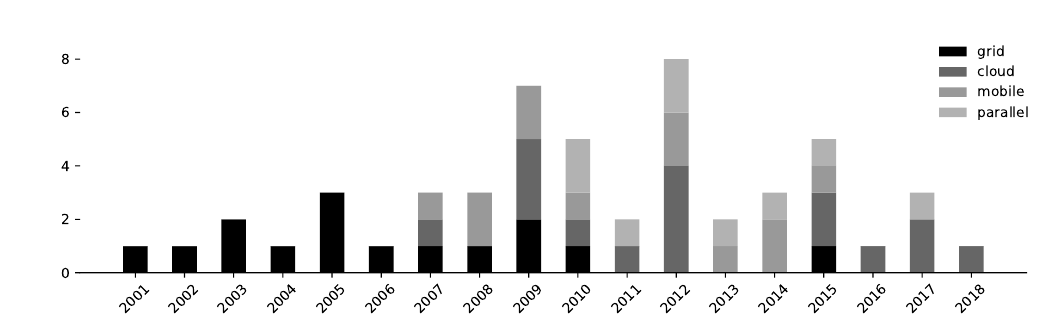
Figure 5. Publishing of VC solution proposals (project papers), data taken from [5].